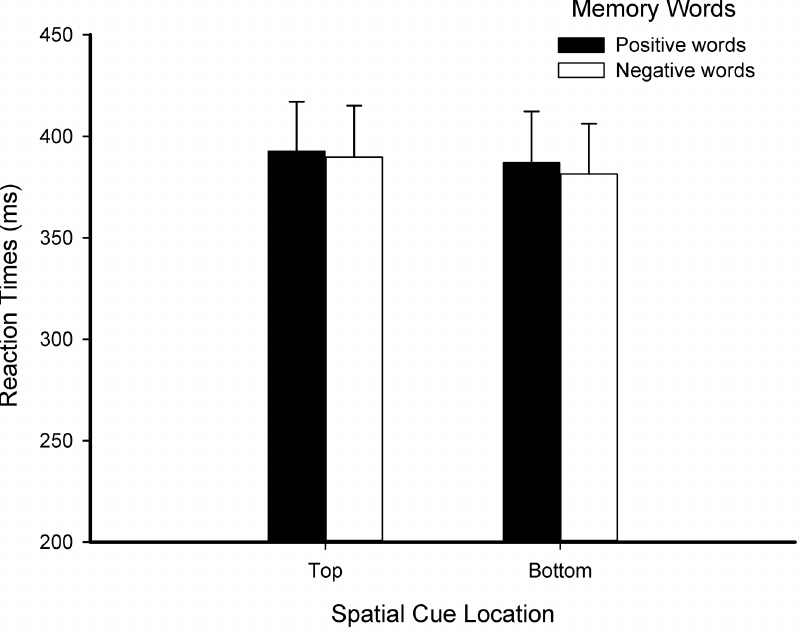
Figure 1. Reaction times for location detection task in Experiment 1.